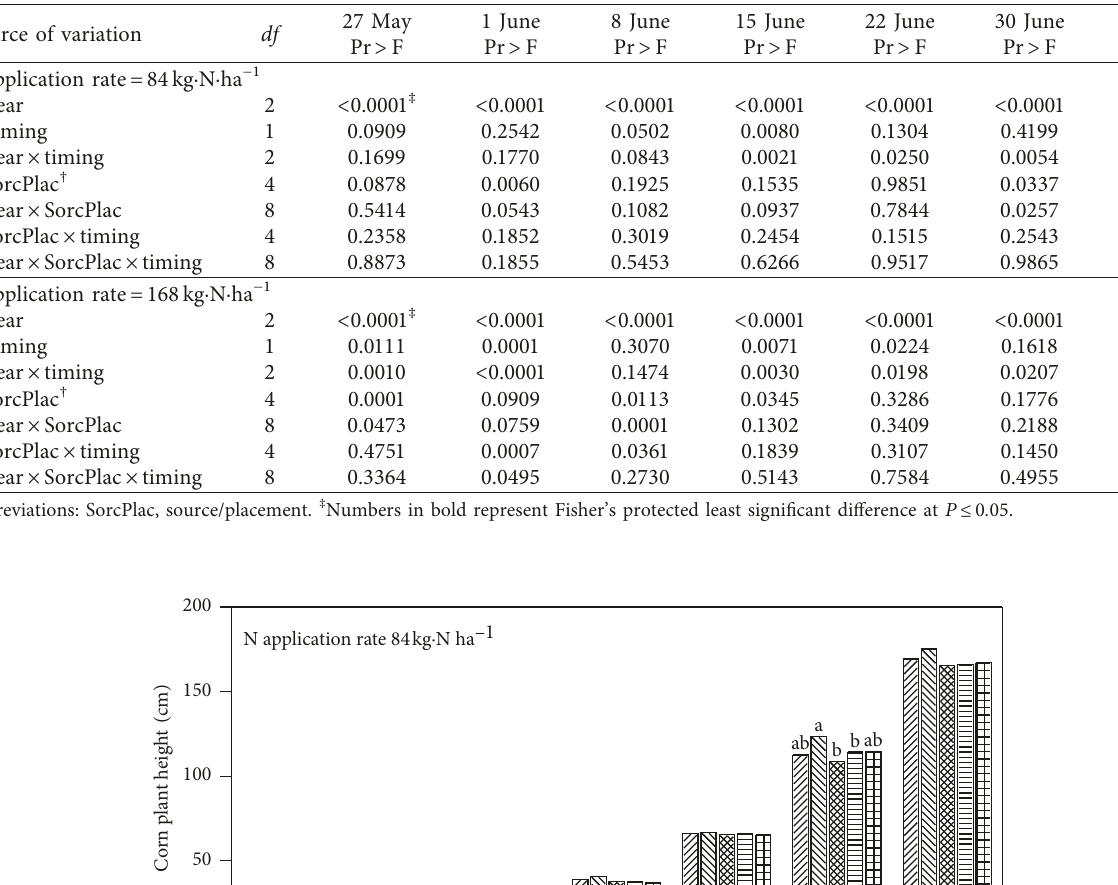
Table 2: The ANOVA table for corn plant heights at 84 and 168kg · N · ha − 1 .